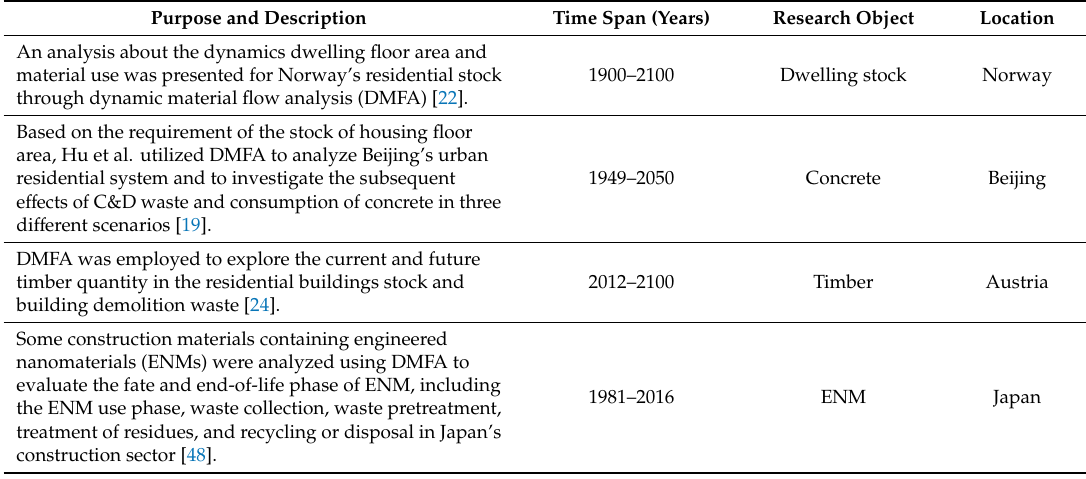
Table 3. Summary and analysis of C&D waste processing based on